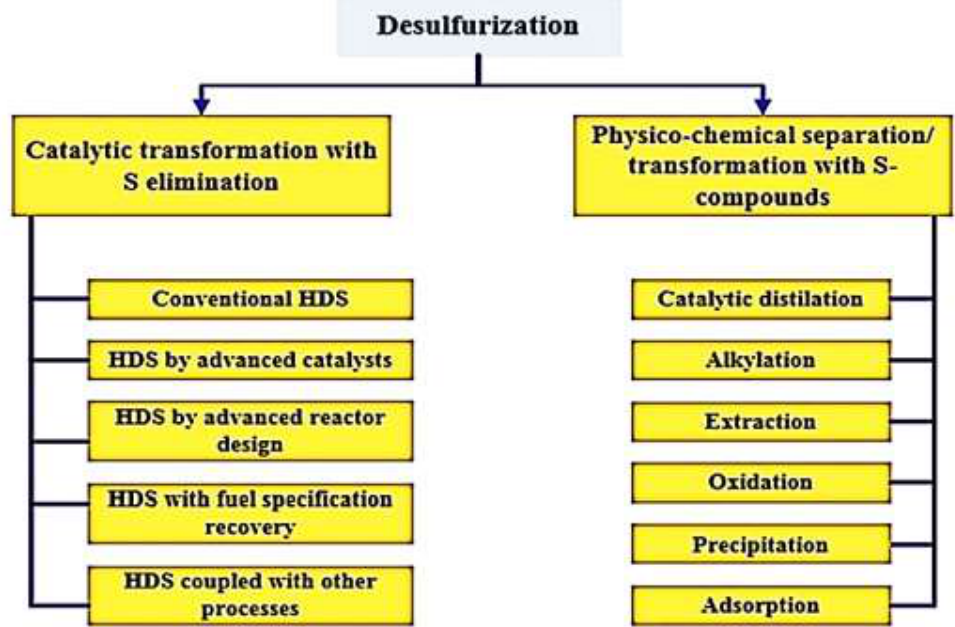
Figure 2 : Classification of various desulfurization technologies Based on the role of hydrogen [22].